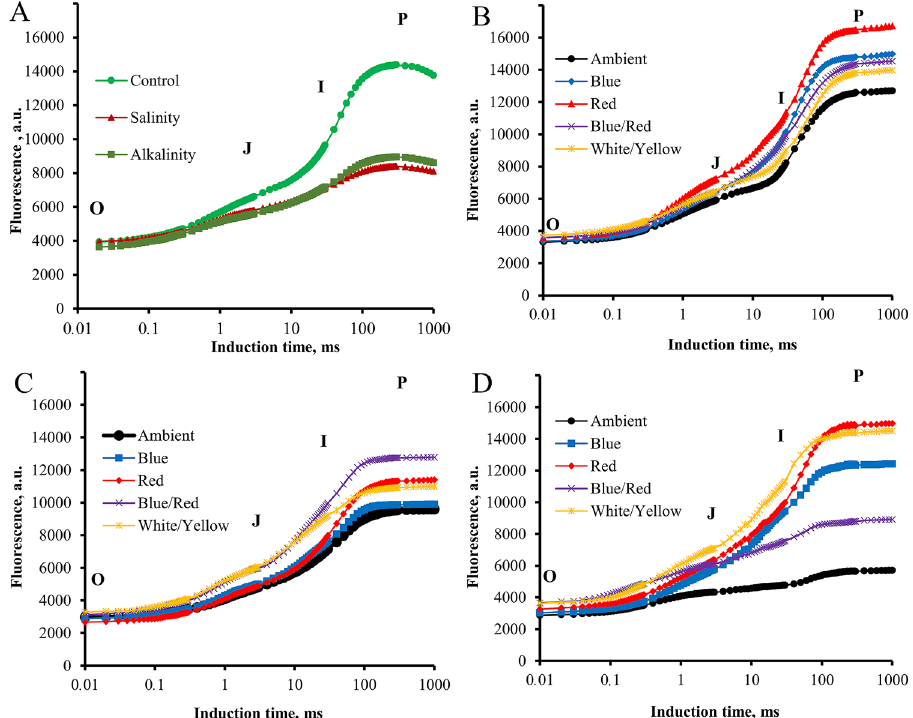
Figure 2. Induction curves of chlorophyll a fluorescence of strawberry cv. Paros. ( A ) In ambient light (control, salt stress, alkalinity stress); ( B ) non-stressed in different light spectra (ambient, blue, red, blue/red, white/ yellow); ( C ) under salt stress in different light spectra (ambient, blue, red, blue/red, white/yellow); ( D ) under alkalinity stress in different light spectra (ambient, blue, red, blue/red, white/yellow). Biophysical parameters were determined with "PEA Plus" software version 1.12 (http:// www. hansa tech- instr uments. com). The graphs were drawn using Microsoft Excel version 2016 (https:// www. micro soft.